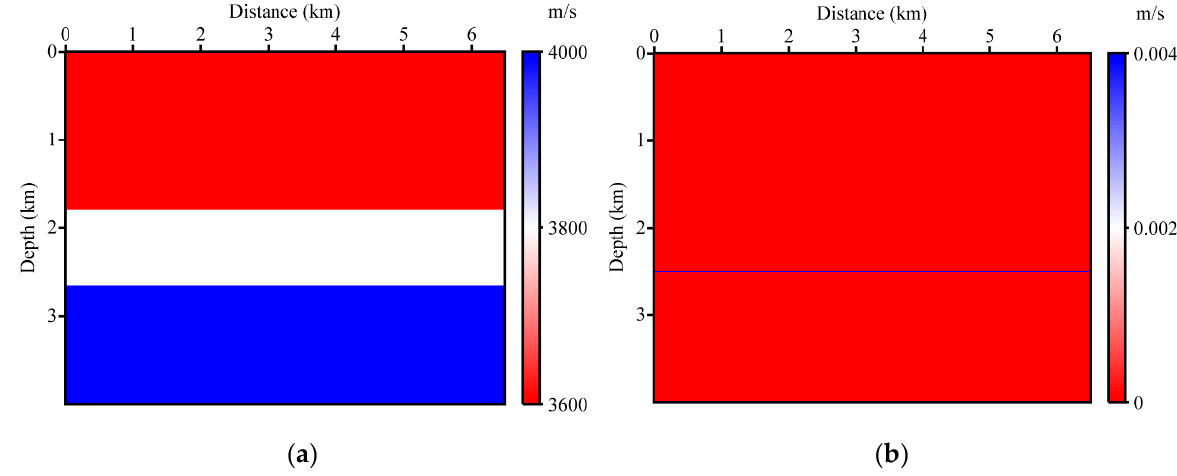
Figure 1. Migration model: ( a ) P-wave velocity; ( b ) Stained target.